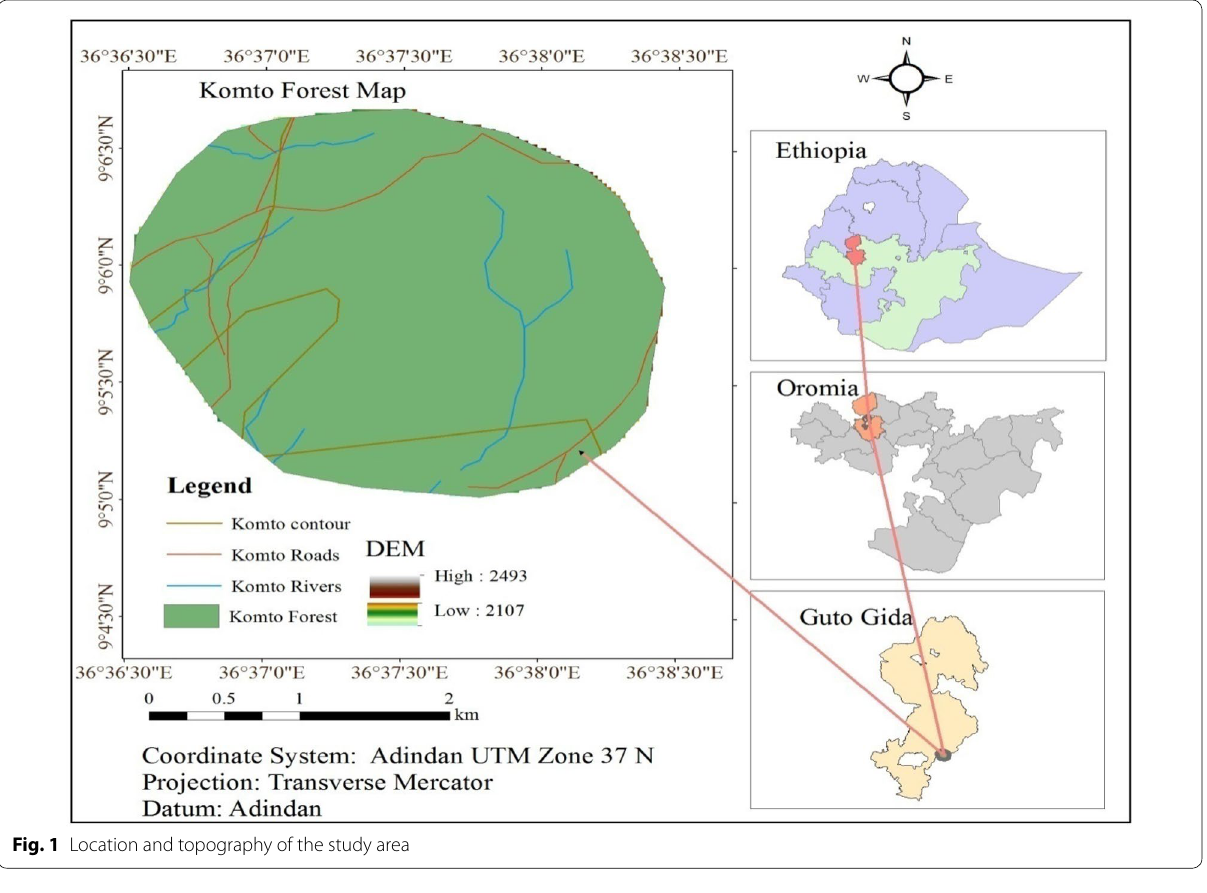
Fig. 1 Location and topography of the study